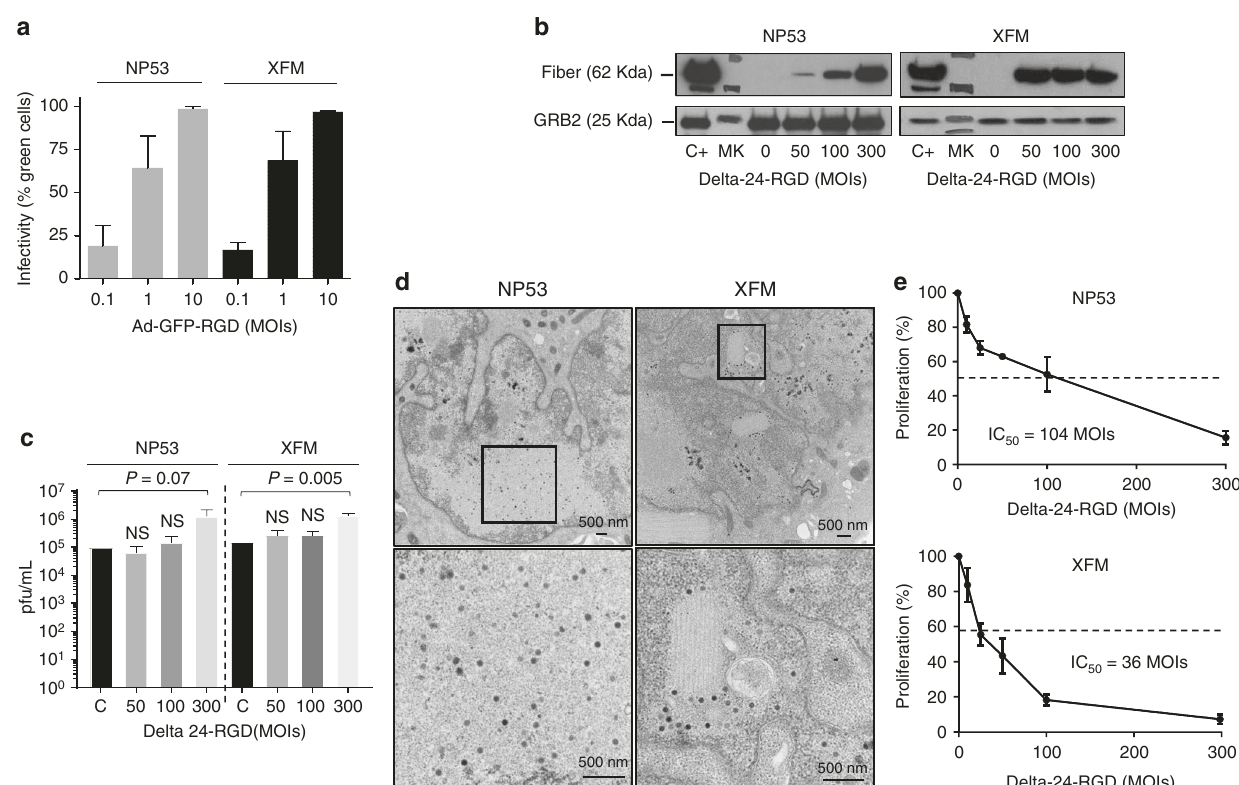
Fig. 4 Delta-24-RGD exerts a potent oncolytic effect in DIPG murine cell lines. a Flow cytometry analyses of infectivity in DIPG murine cell lines. The indicated cell lines were infected at 0.1, 1, and 10 MOIs with a replication-de fi cient construct expressing a modi fi ed fi ber knob (AdGFP-RGD). The data are shown as the relative percentage (mean ± SD) of GFP-positive cells scored among 10,000 cells per treatment group. b Western blot analysis of late protein fi ber expressed in murine cell lines 42 h after infection at different viral doses and a human positive control (C + ). MK = Marker. A representative blot is shown of three independent experiments. c Quanti fi cation of Delta-24-RGD replication in the indicated cell lines. Viral titers were determined 3 days after infection at MOIs of 50, 100, and 300 and control (C) that corresponds to infected cells with 300 MOIs recollected at 16 h by an anti-hexon staining-based method in 293 cells and expressed as plaque-forming units (pfu) per milliliter. The data are shown as the mean ± SD of three independent experiments, two-tailed Student t test analysis was used for comparison. d Representative electronic microscopy images showing viral progeny 72 h after viral infection of the NP53 (300 MOIs) or XFM (200 MOIs). e Cell proliferation analyses of Delta-24-RGD-infected DIPG murine cell lines. Cell viability was assessed using an MTS assay 5 days after infection. The data are shown as the percentage (mean ± SD of three independent experiments) of cells alive after infection with Delta-24-RGD at the indicated multiplicities of infection (MOIs) relative to the non-infected cells (control, equal to 100%). Source data are provided as a Source Data fi